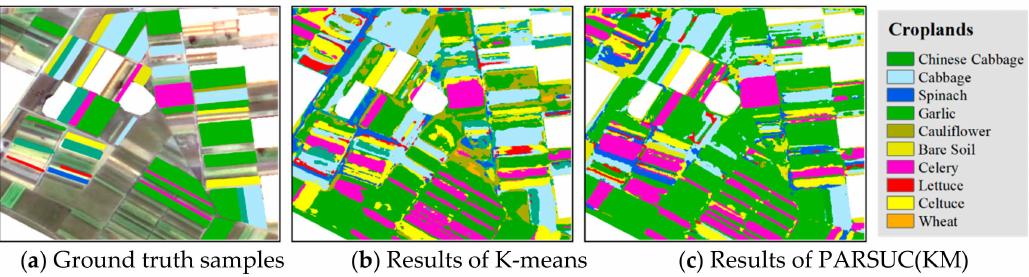
Figure 9. Ground truth samples, classification results of PARSUC(KM) and K-means at region 1.